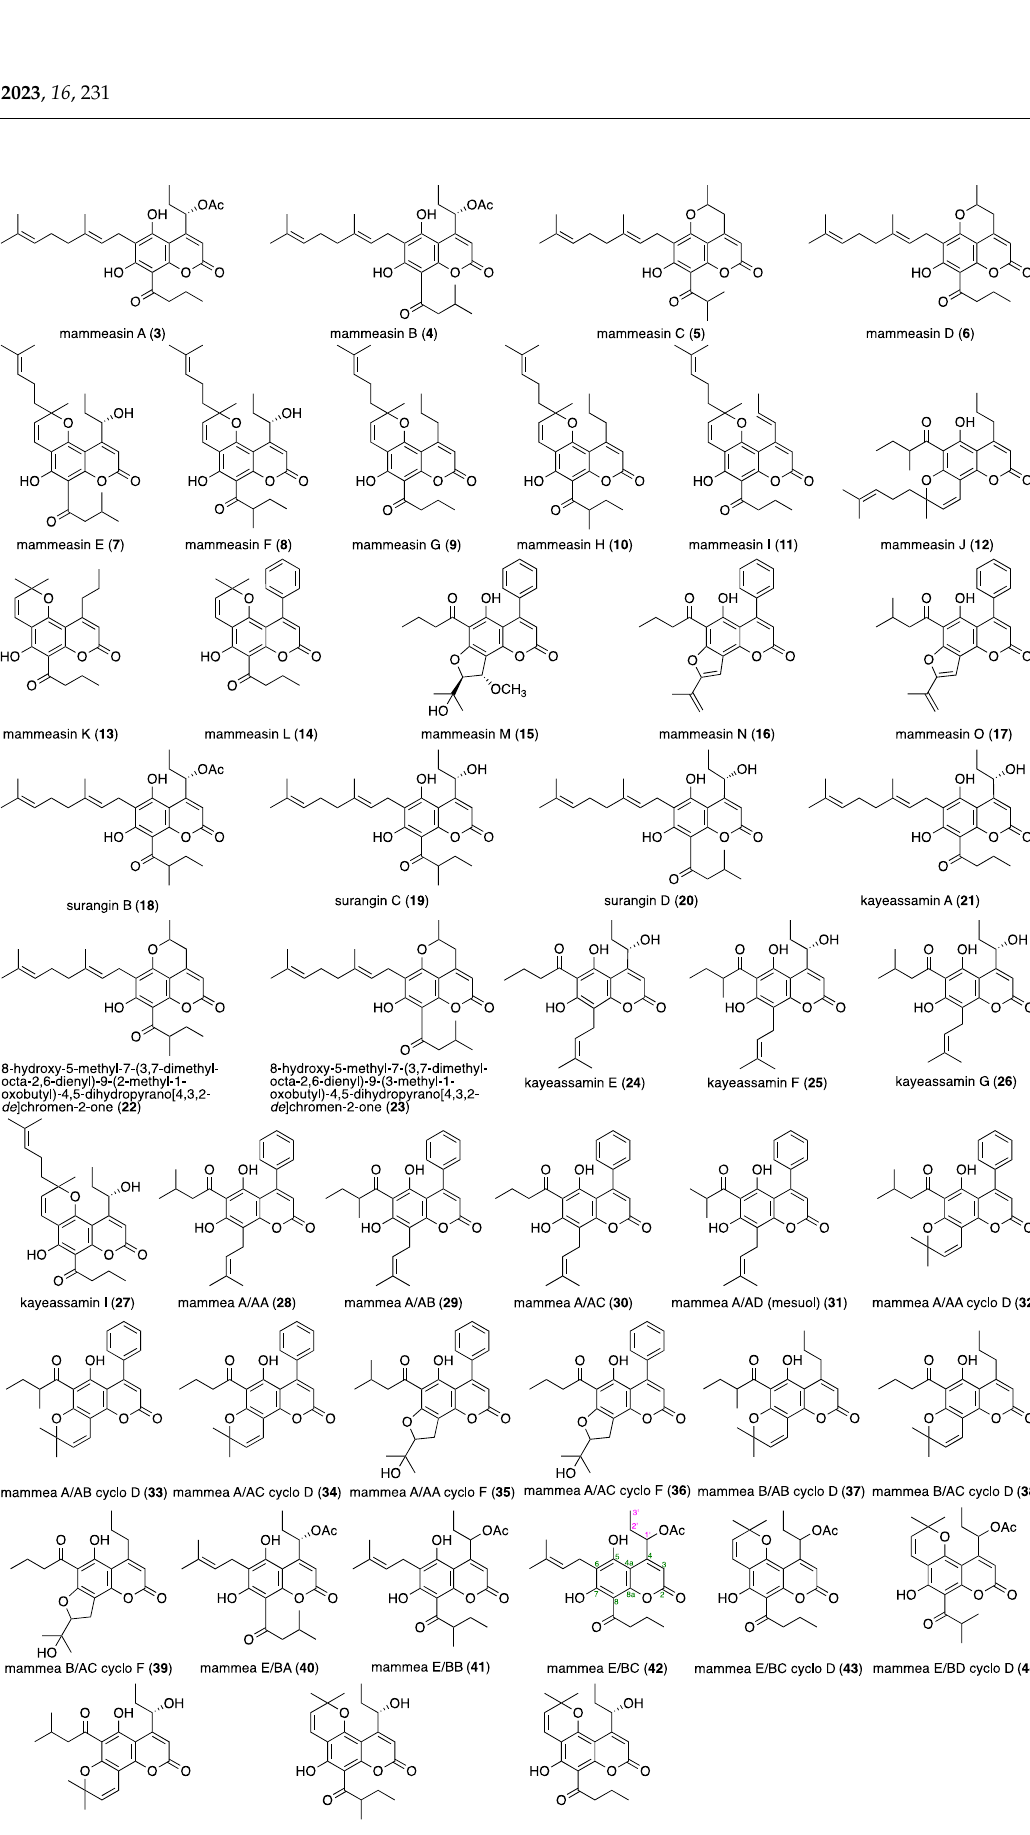
Figure 4. Coumarin constituents ( 3 – 47 ) from the flowers of M. siamensis